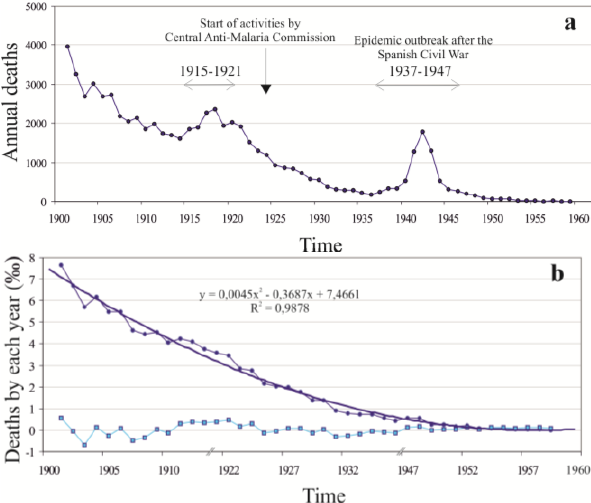
Figure 1. ( a ) Evolution of mortality by autochthonous malaria in Spain. ( b ) Proportion of deaths by malaria in relation to the total mortality between 1900 and 1959 (the years 1915–1921 and 1937–1947 are not